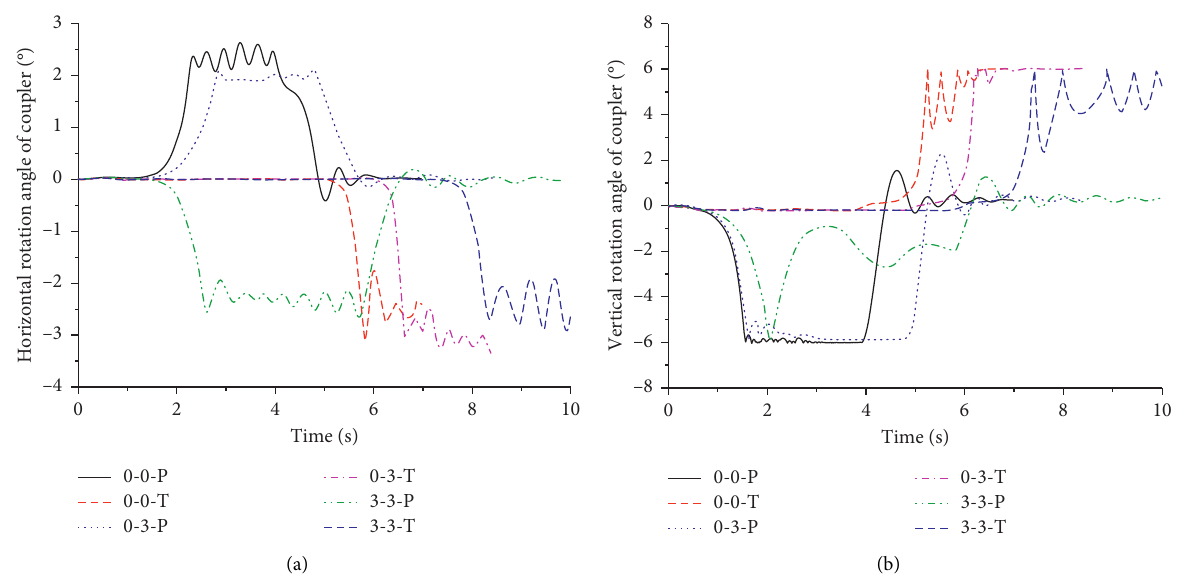
Figure 11: Coupler dynamic behavior. (a) Horizontal rotation angle. (b) Vertical rotation angle.